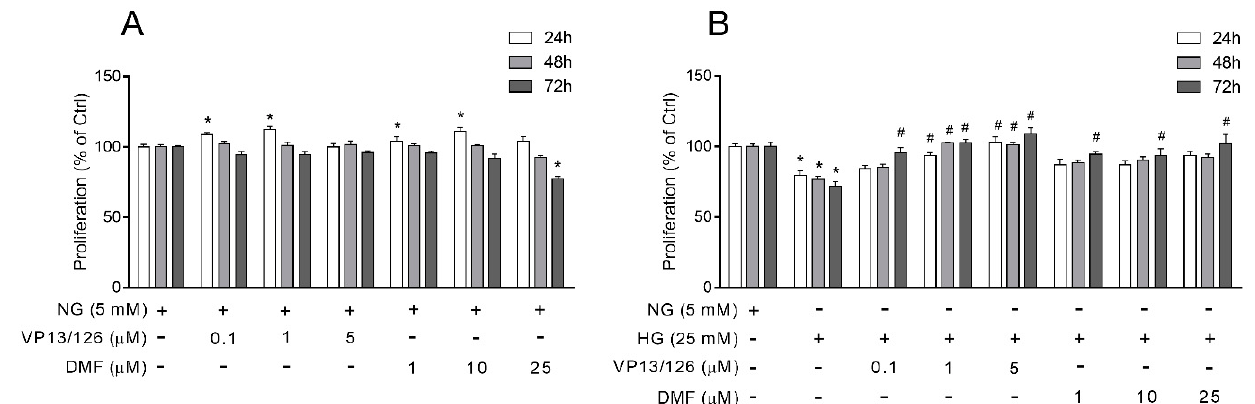
Figure 3. Effects of VP13/126 and DMF restored cell proliferation of SIRC challenged with high glucose. Crystal violet assays were performed in cells cultured for 24, 48 and 72 h with normal glucose (Ctrl, 5 mM) in presence of increasing amounts of VP13/126 (0.1, 1 and 5 µ M) or DMF (1, 10 and 25 µ M) ( A ). Cells were treated with high glucose (HG, 25 mM) supplemented with increasing amounts of VP13/126 (0.1, 1 and 5 µ M) or DMF (1, 10 and 25 µ M) were also tested in MTT assays ( B ). Data are shown as a mean ± SEM of n = 3 independent experiments, each run in triplicate. * p < 0.05 vs. Ctrl; # p < 0.05 vs. HG alone in the respective conditions. Two-way ANOVA, followed by Tukey’s test.